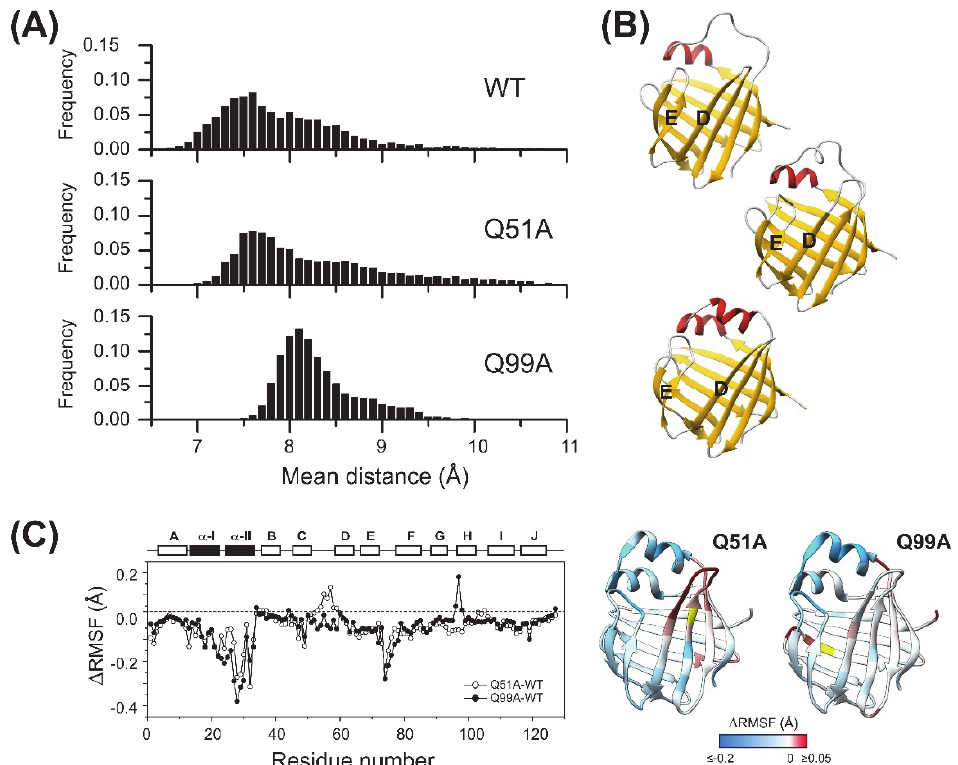
Figure 9. Structural and dynamic differences between the investigated apo human I ‐ BABP variants as revealed by MD simulations at 283 K. The openness of the ligand entry portal of apo hI ‐ BABP was inspected by the distance between the D and E β ‐ strands. ( A ) Distributions of the average distance between backbone C α atom ‐ pairs of the two β ‐ strands are shown (see Methods ). ( B ) Representative structures for the most populated conformations regarding the D ‐ E distance for the three variants. Q99A exhibits a more open conformation than WT and Q51A along the MD trajectories. ( C ) Differ ‐ ences in RMSF values between the mutants and WT apo hI ‐ BABP at 283 K. Results are shown for the most populated protonation state at pH 6.3 with all three histidine residues are protonated. Values of Δ RMSF are mapped on the ribbon diagram of apo hI ‐ BABP (PDB: 1O1U [15]) for the two mutants in a blue ‐ to ‐ white ‐ to ‐ red gradient with blue and red colors corresponding to decreased and in ‐ creased flexibility, respectively, relative to wild ‐ type. The position of the mutations is indicated in yellow.